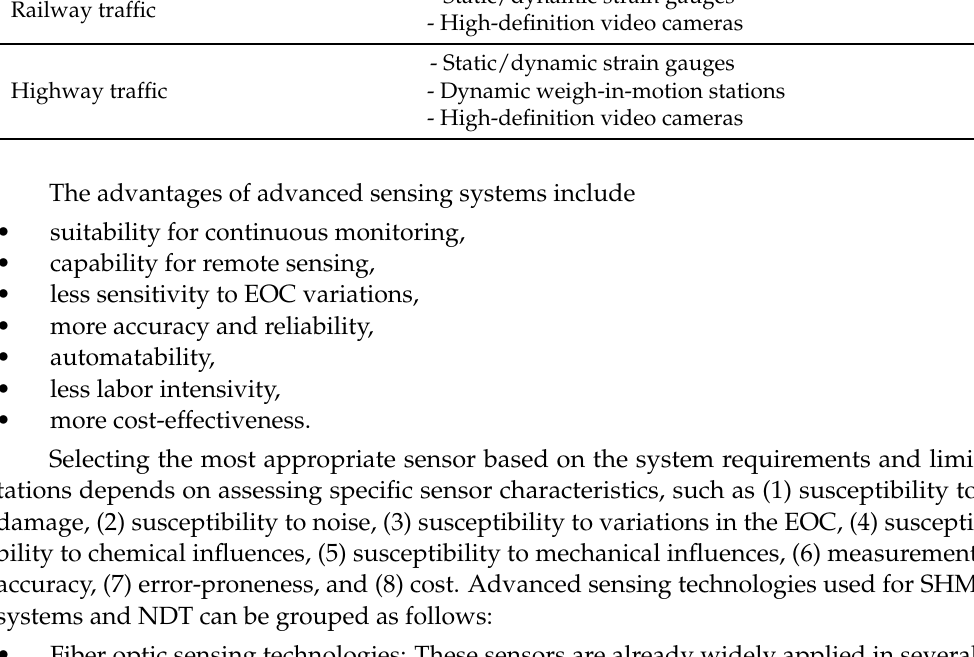
- Fiber optic sensors